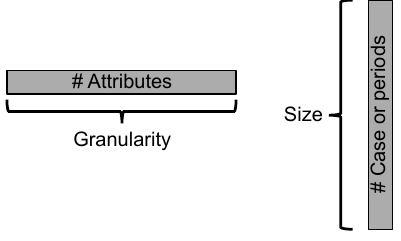
Fig. 1 Granularity and size of